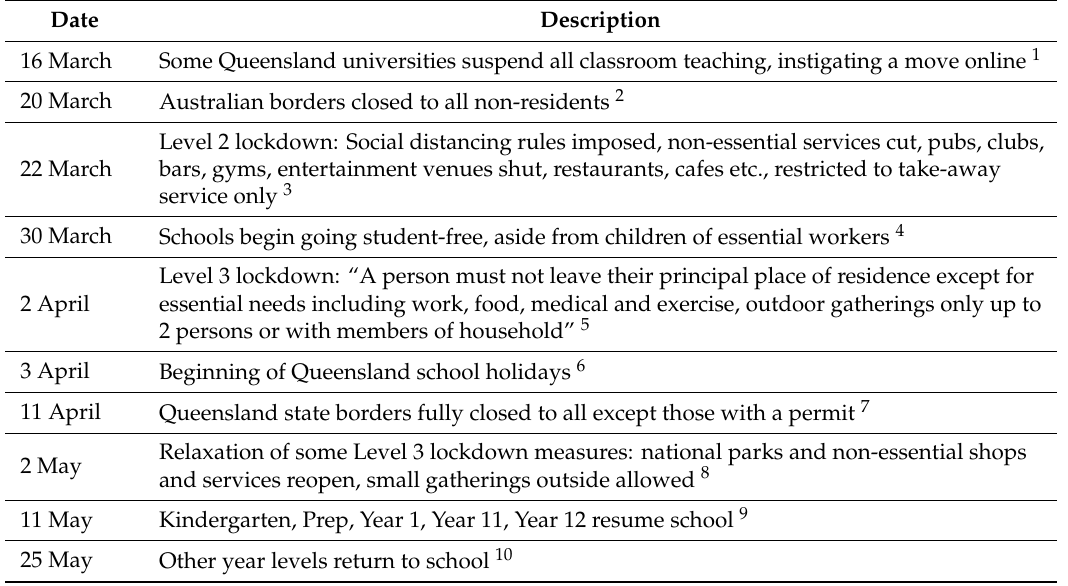
Table 1. Indicative timeline of COVID-19 lockdown in